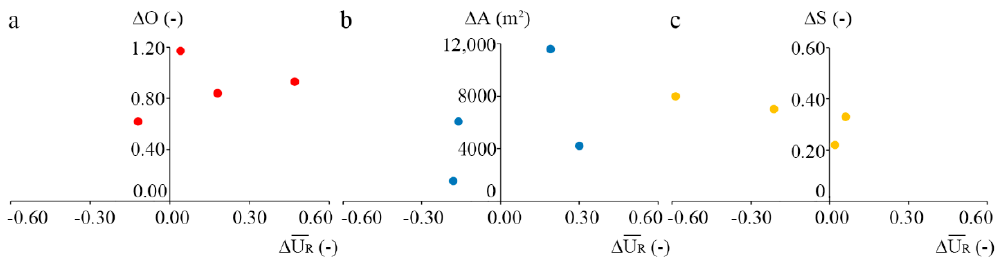
Figure 13. Scatter diagrams of the difference value of spatial characteristics’ indices （ △ O, △ A, △ S ） and the difference value of the mean wind speed ratio ( △U R